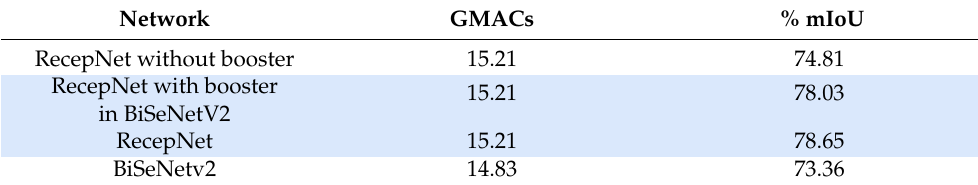
Table 10. Performance of training booster